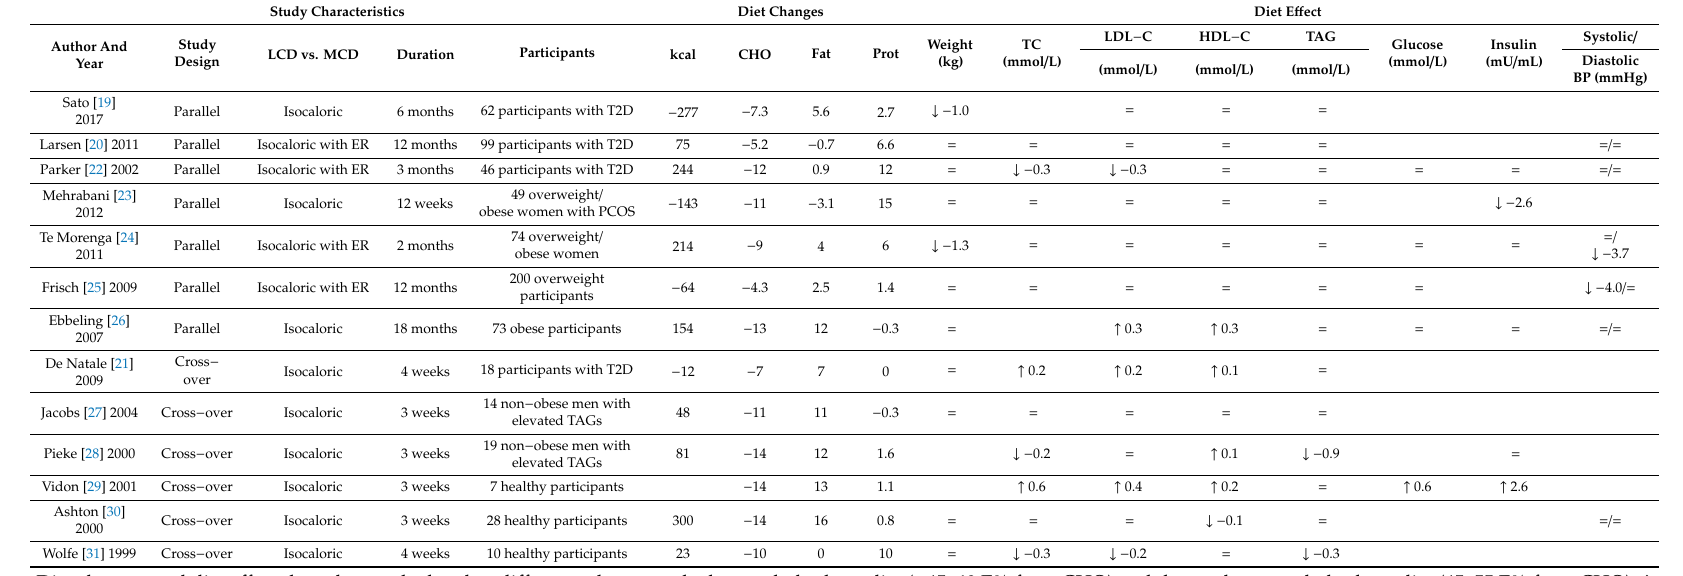
Table 1. Overview of the moderate low-carbohydrate diets ( < 45–40 E%) and their e ff ects on cardiometabolic risk